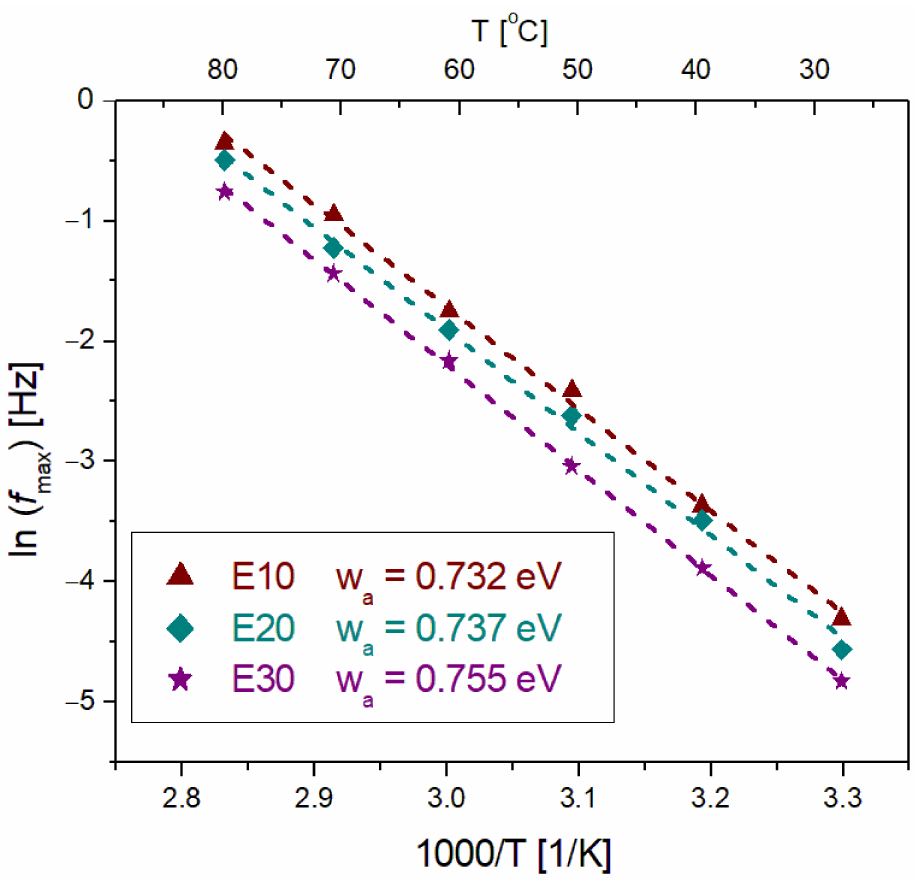
Figure 13. Dependence of log f max on the inverse temperature for the peak of tan δ ( f ) variation for polysiloxane–nanosilica nanodielectrics with 10, 20 and 30 wt% filler